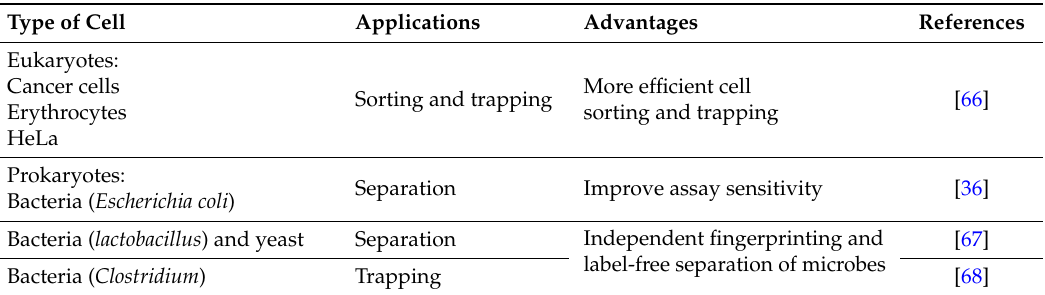
Table 2. DEP investigations of eukaryotic and prokaryotic